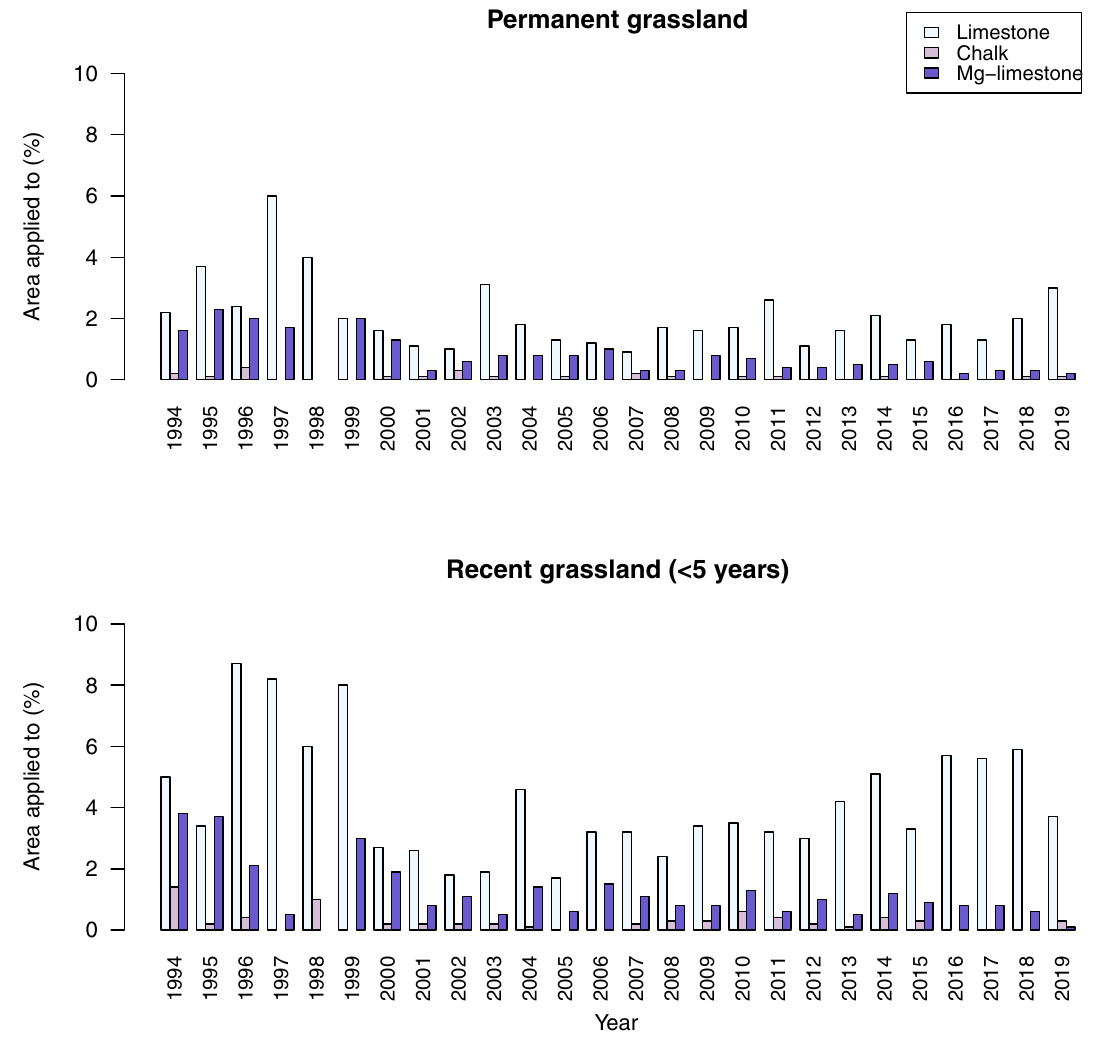
Figure 4. Limestone, chalk and high magnesium limestone (Mg-lime) application to ( a ) permanent and ( b ) recent grassland for Great Britain, from the annual British Survey of Fertiliser Practice 1994–2019 publications DEFRA 26 , https:// www. gov. uk/ gover nment/ colle ctions/ ferti liser- usage). Note that data for limestone and